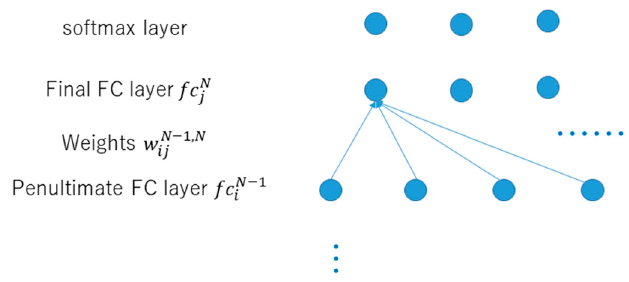
Figure 1. Last two Full connection (FC) layers of convolutional neural network (CNN). The flowchart of defining the D-measure is shown in Figure 2.